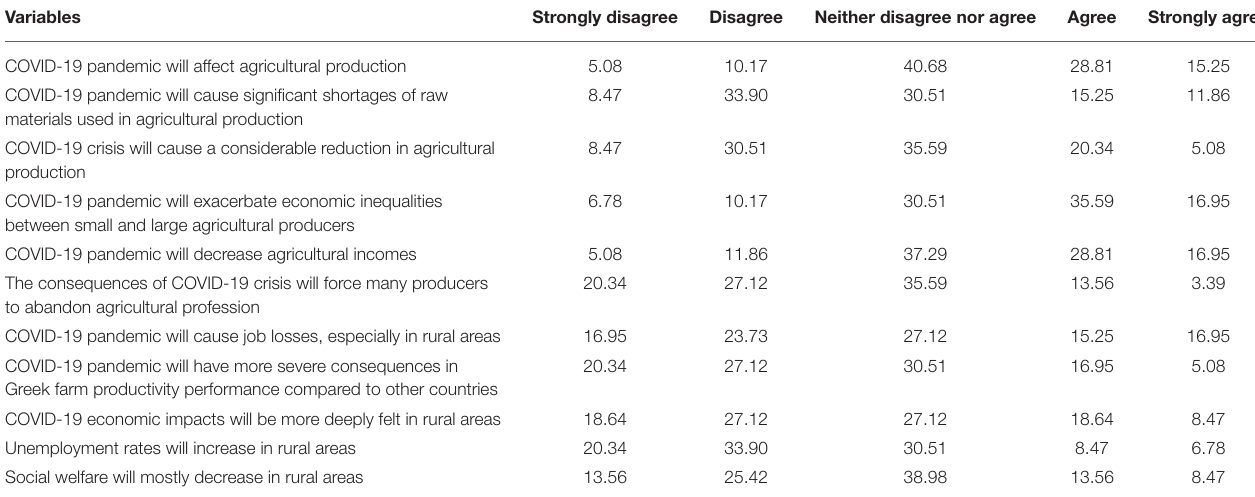
TABLE 2 | Experts’ perceptions toward COVID-19 impacts on agriculture (%).